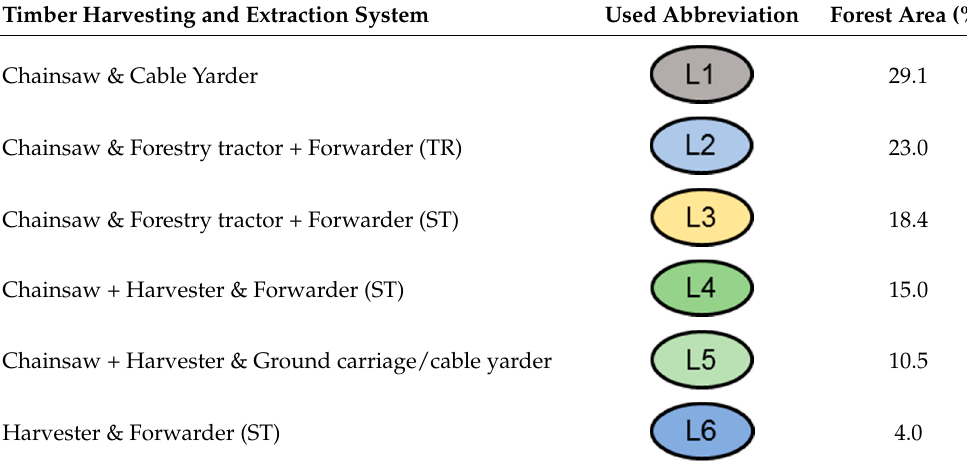
Table 6. Proportion of different felling and hauling systems (in %) applied in six selected Forest